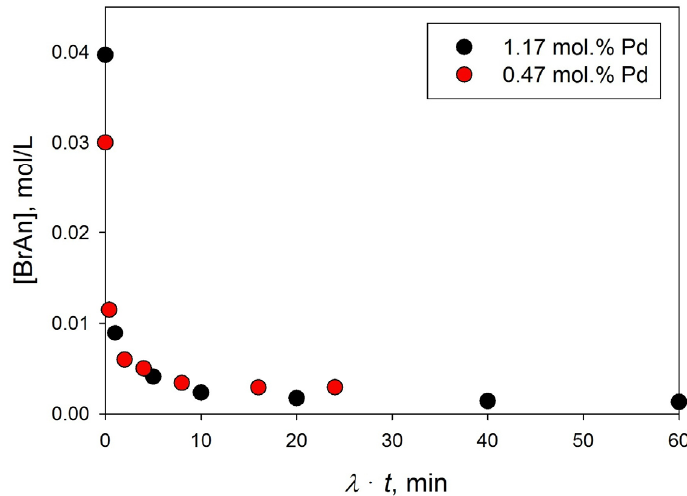
Figure 7. Dependence of the current concentration of BrAn on “conditional” reaction time in a series of experiments with different amounts of Pd(II)/HPS catalyst (black circle—1.17 mol.%, red circle—0.47 mol.%).